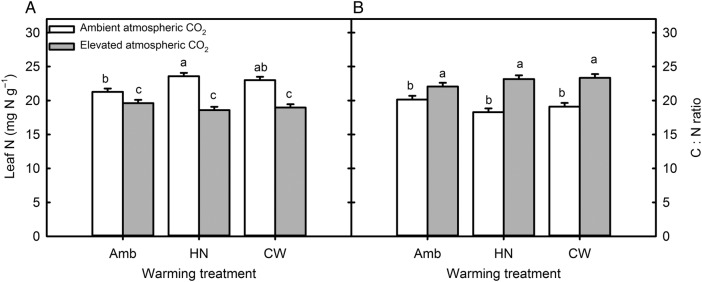
Effect of warming treatment, Amb = ambient temperature, HN = +2.2/+4.0 °C (day/night warming), CW = +3.0 °C continuous warming and atmospheric CO2 concentration (ambient, 405 p.p.m., and elevated, 756 p.p.m.) on (A) green leaf N concentration and (B) green leaf C : N ratio. Data presented are least square means and SEM averaged across harvests and clipping frequencies. Different letters indicate statistically significant differences at P <0.05 using Student's t LSD test.